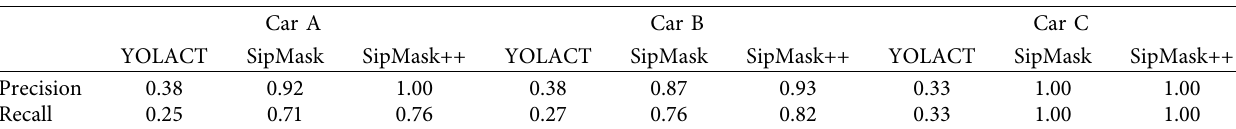
Table 6: Precision/recall analysis of part-level accuracies for Cars A, B, and C for the three algorithms including YOLACT, SipMask, and